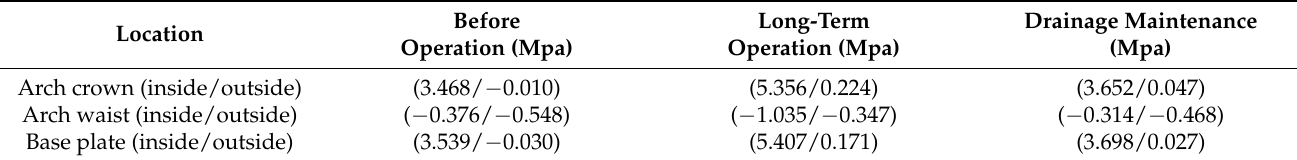
Table 4. Maximum principal stress of the lining.